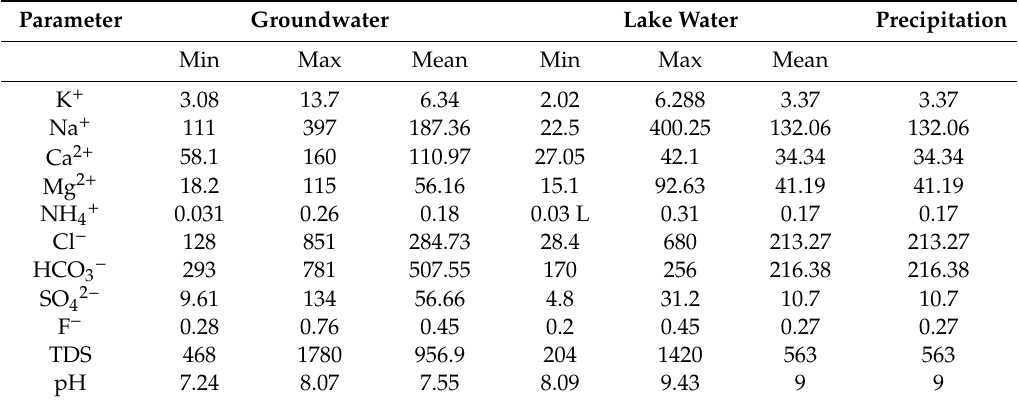
Table 1. Statistical analysis results for major ion concentrations (mg / L) in groundwater and lake water.